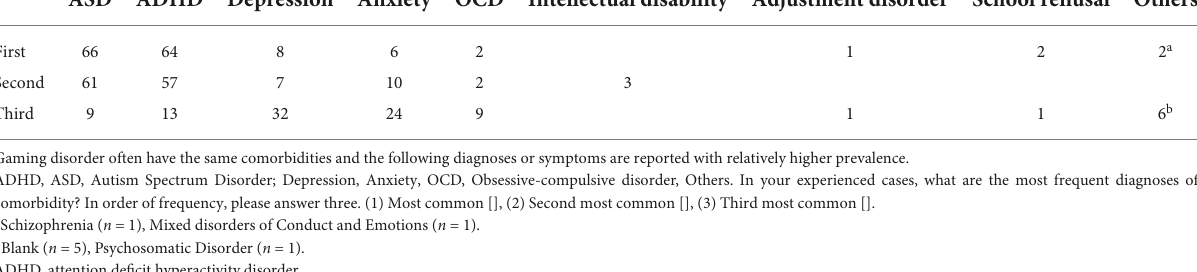
TABLE 3 Comorbidities of gaming